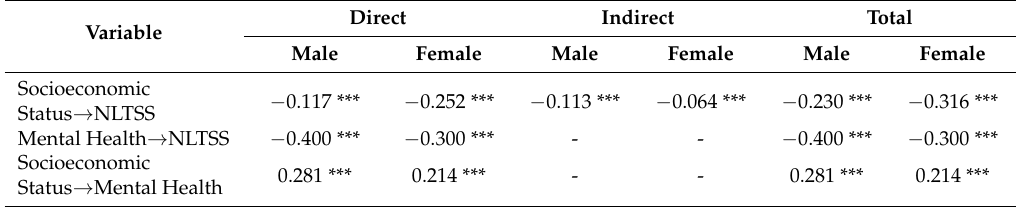
Figure 2. Structural equation modeling analysis of the association between SES, mental health and NLTSS of the female elderly ( n = 7070). Employing the cross-sectional data, relationship between SES, mental health and NLTSS were analyzed. Arrows indicate the associations and directions between variables, double curved arrows indicate correlation between each factor. All parameter estimates were statistically significant ( p < 0.001). Note: χ 2 = Chi square; GFI = Goodness of Fit Index; AGFI=Adjusted Goodness of Fit Index; CFI = Comparative Fitness Index; RMSEA = Root-mean Square Error of Approximation; LTSSN = Long-term Services and Supports needs; SES = Socioeconomic Status; NLTSS = Need for Long-term Services and Supports. Table 6. Standardized Effects between Socioeconomic Status, Mental Health and NLTSS by